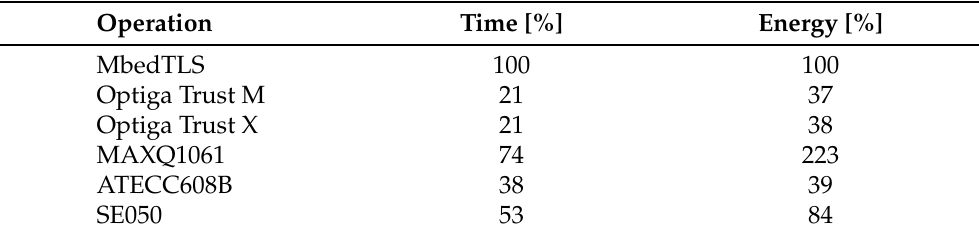
Figure 14. Time and energy measured for a DTLS handshake relative to the reference implementation. (median of values, rounded to the nearest percent, n = (see Table 6)). Table 7. Table of values for Figure